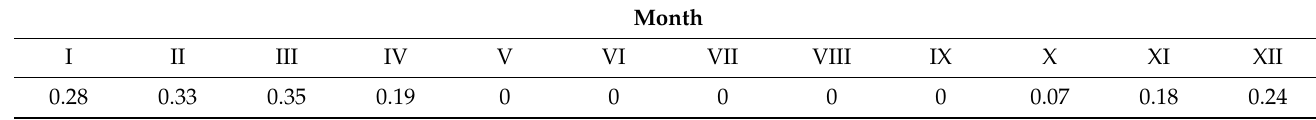
Table 3. Snow depth (m) average over the last 12 years at Amga meteorological station.